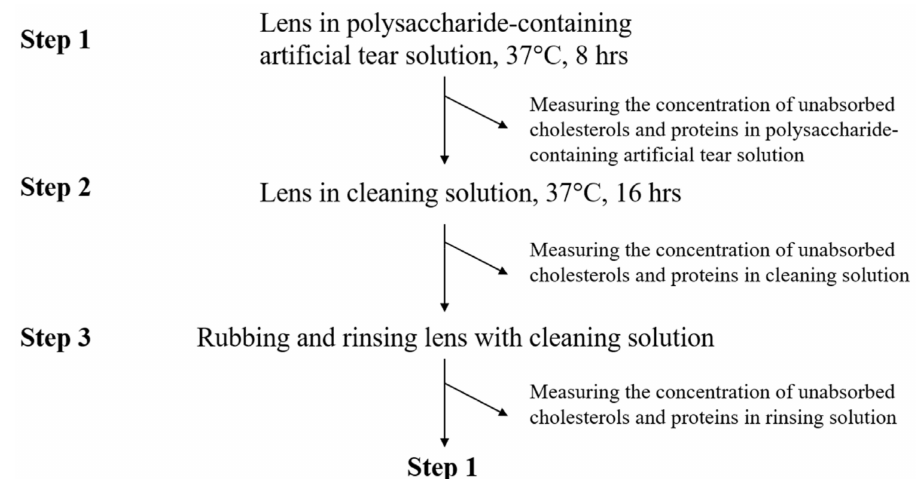
Figure 1. The procedure of cholesterol and protein adsorption analysis. One completed cycle is from step 1 to step